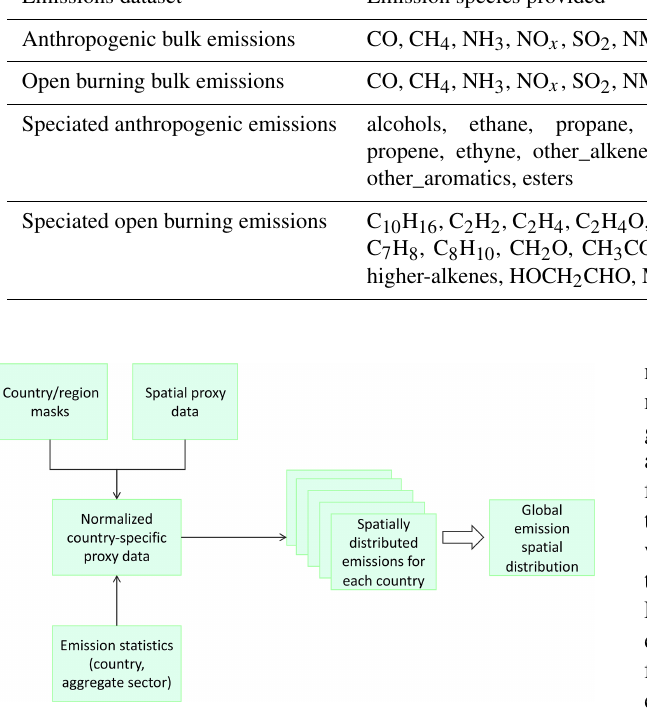
Figure 1. Emissions gridding overview. Emissions data at the coun- try and aggregate sector level are mapped to spatial grids separately by country and sector, then combined into global emissions grids as described in the main